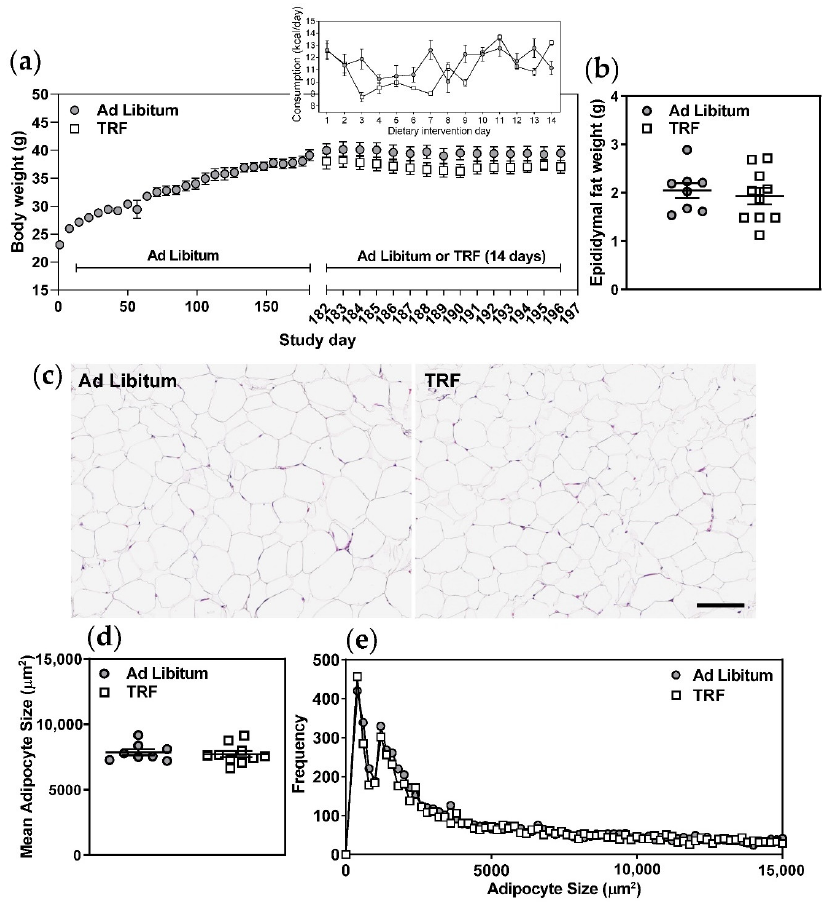
Figure 1. Two-week TRF does not significantly alter body weight, adipocyte size, or adipocyte size distribution in obese mice. ( a ) Body weights and food consumption (inset) were recorded on the indicated days. ( b ) Epididymal fat pads were excised and weighed post mortem. ( c ) Epidydimal adipose tissue sections were stained with hematoxylin and eosin (HE) to visualize tissue morphology. ( d , e ) Images were analyzed using AdipoCount to determine adipocyte number per image and individual adipocyte areas (adipocyte size). Mean adipocyte areas were calculated and adipocyte size frequencies were plotted. Scale bar represents 100 µm, n = 8–10.